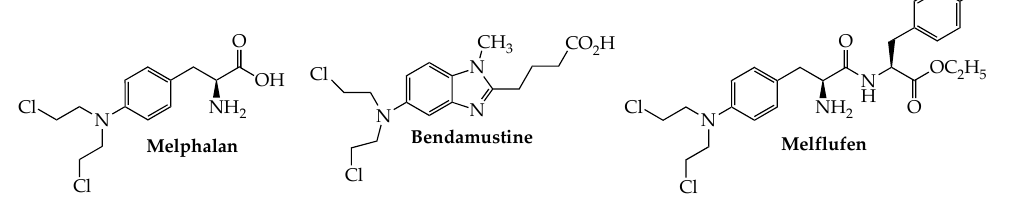
Figure 1. Structures of Alkylating Agents with Activity Against Multiple Myeloma.